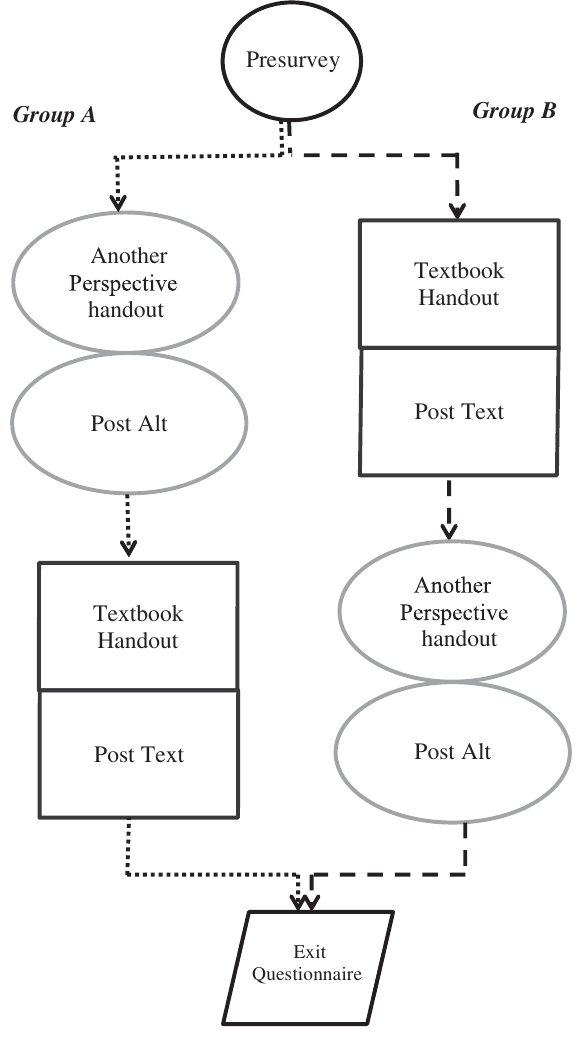
FIG. 3. Flow chart of activities for groups A and